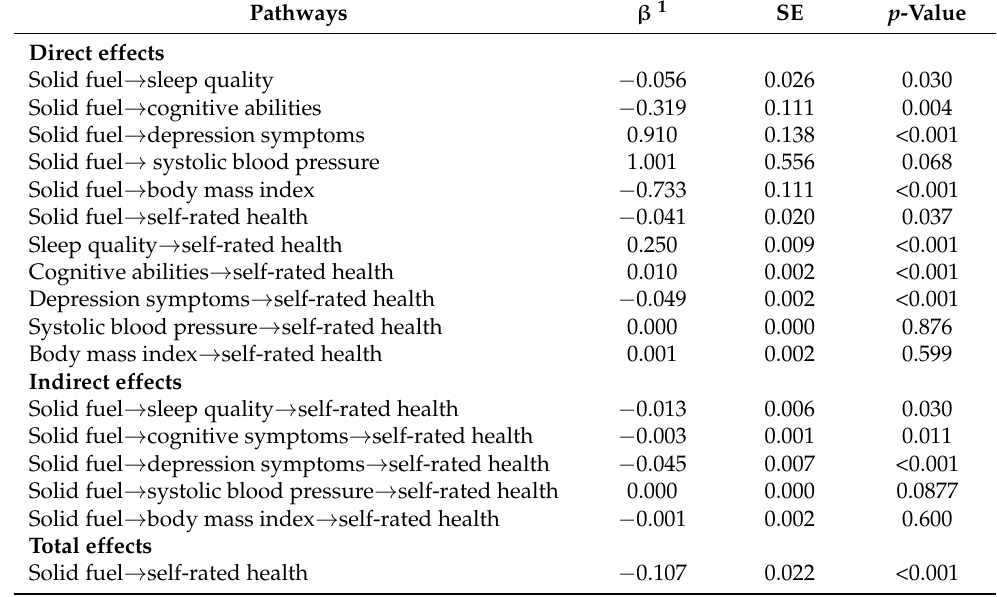
Table 2. Direct, indirect, and total effects of solid fuel use on self-rated health. Pathways